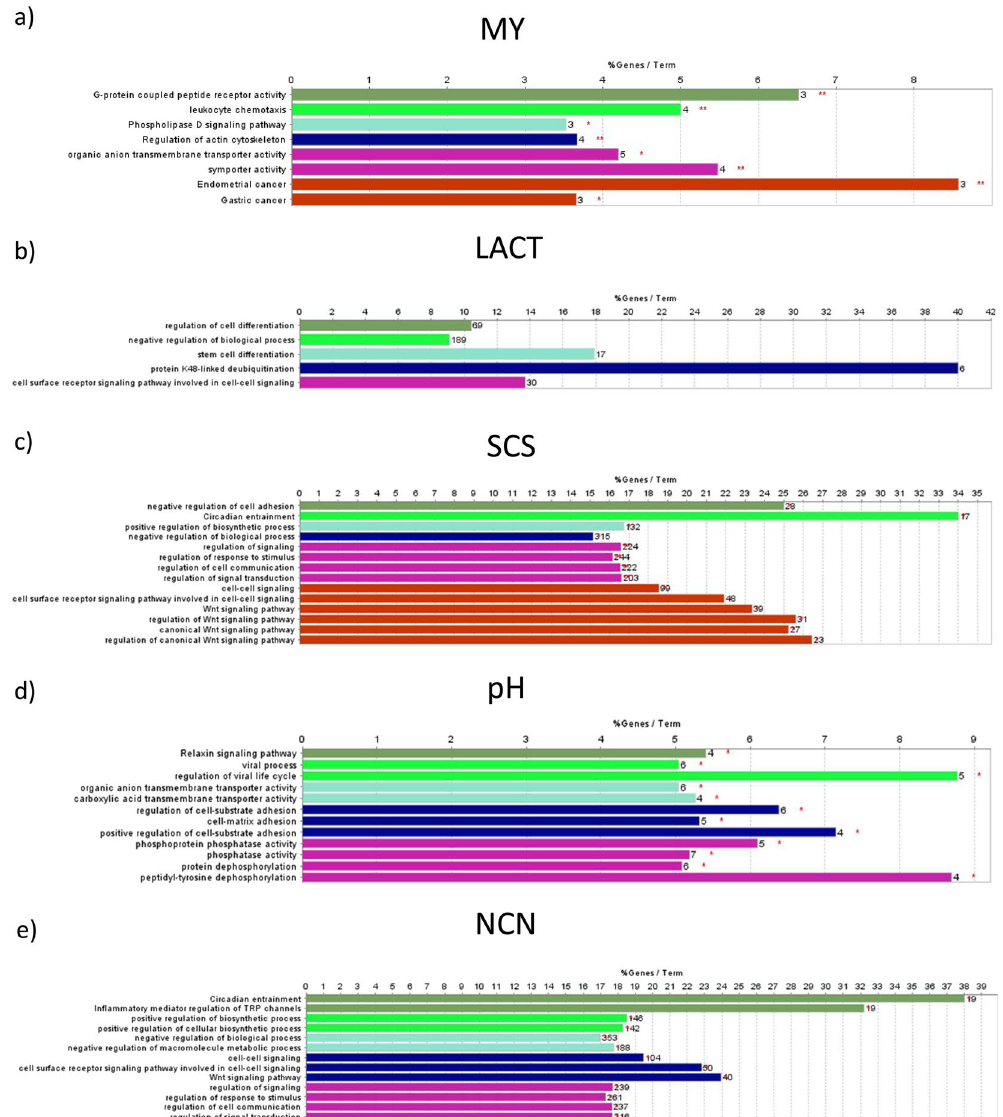
Figure 8. Significantly enriched GO terms and KEGG pathways for the investigated traits. ( a ) Milk yield (MY); ( b ) Lactose (LACT); ( c ) Somatic cell score (SCS); ( d ) Milk pH (pH); ( e ) Non-casein N (NCN, expressed as % of total milk N). SNPs obtained from MTM-GWAS ( P < 0.05) were mapped to genes based on 15 kb distance from the coding region using the biomaRt R package 40,41 . The Cytoscape plugin Cluego 43 was used to identify overrepresented pathways and GO terms based on a right-sided hypergeometric test with false discovery rate set at